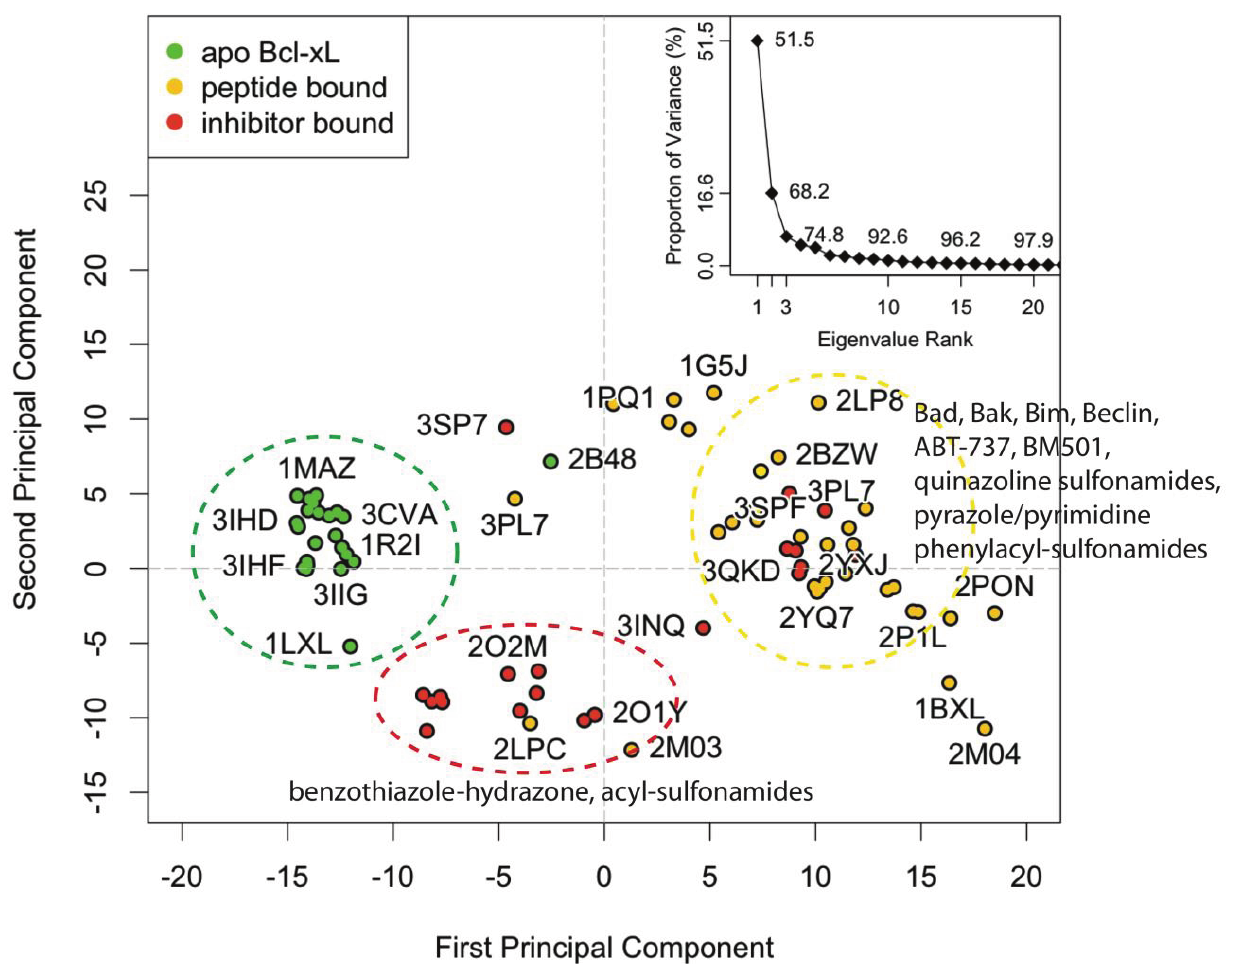
Figure 1. The PC subspace for the BH3-domain binding pocket of Bcl-xL experimental structures contains three general conformational groupings. The group furthest to the right (yellow circle) is dominated by peptide-bound conformations, in which α 3 and α 4 are shifted downward with respect to the apo structures (green circle). Meanwhile, the benzathiazole-hydrazone and acyl-sulfonamide inhibitor-bound structures (red circle) have an upward shifted α 3 and α 4 and a rightward shifted α 3 with respect to the peptide-bound